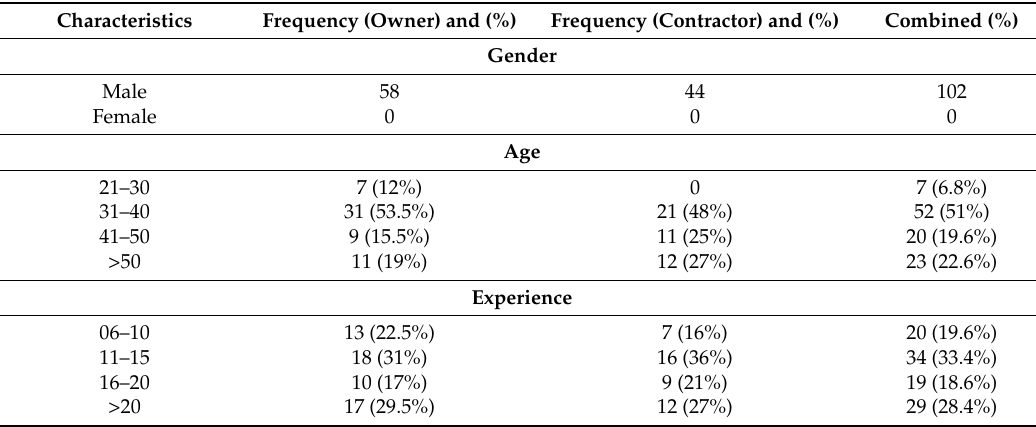
Table 2. Demographic Characteristics of the